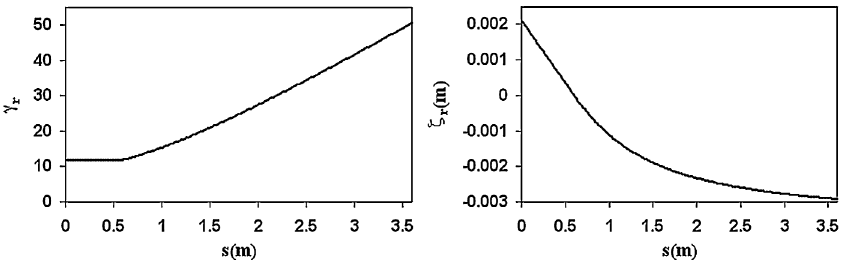
.FIG. 1. Example of electron reference orbit through an rf compressor obtained by numerical solution of Eqs. (1) and (2). The left picture shows the evolution of the relativistic (cid:2) factor, the right picture the relative longitudinal distance between the reference electron and an imaginary particle traveling at the speed of light. (The relevant parameters are k ¼ 12 (cid:2) r 0